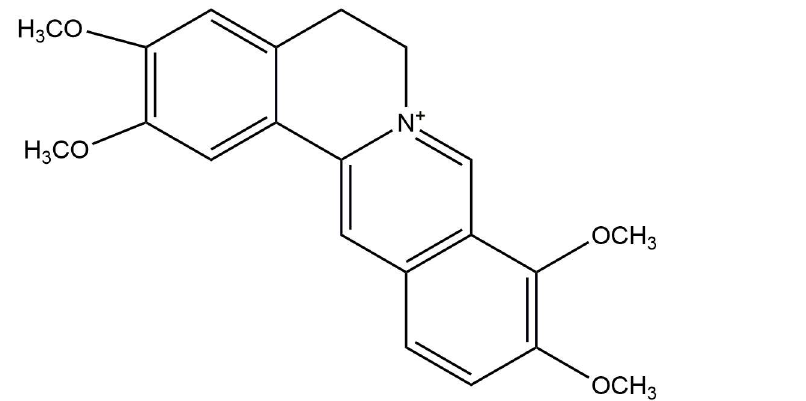
Fig 1. Chemical structure of